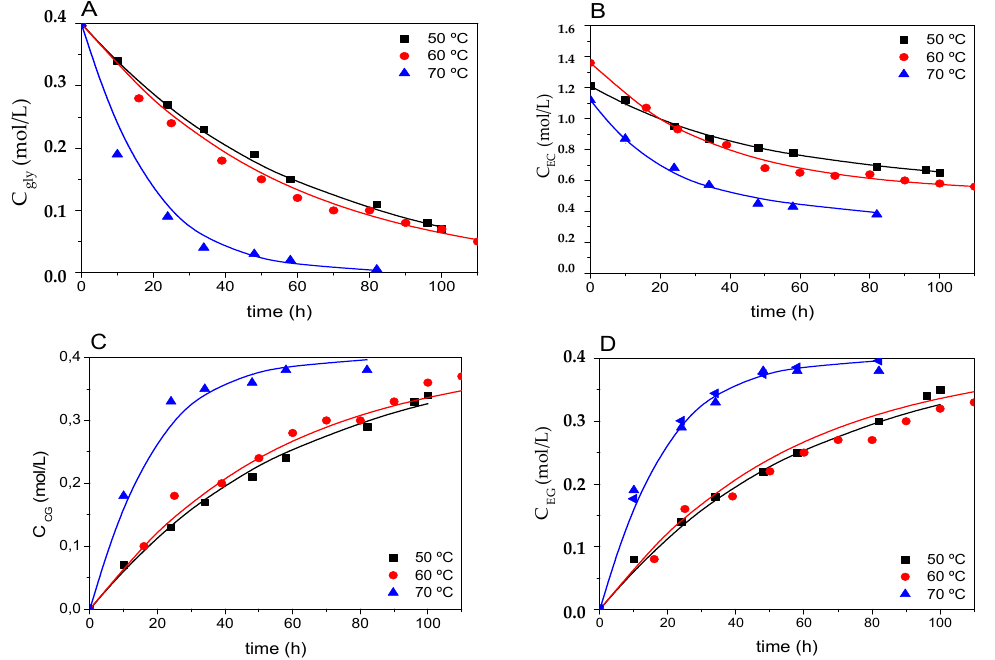
Figure 11. Fitting of the kinetic model proposed to runs 1, 4, and 5 (50 °C , 60 °C , and 70 °C , respectively). Subfigure ( A ) shows results for glycerol, ( B ) for ethylene carbonate, ( C ) for glycerol carbonate, and ( D ) for ethylene glycol. Other conditions: enzyme load: 3% w / w ; solvent: tert-butanol (30% v / v ); closed stirred batch reactor; agitation speed: 400 rpm; molar ratio EC:Gly 1:3.